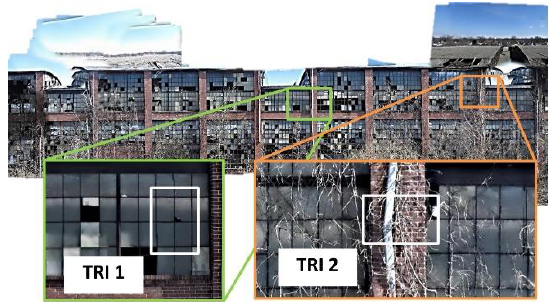
Figure 7. Selection of two sample TRIs (TRI 1 and TRI 2) on the orthophoto. Sensors 2018 , 18 , x FOR PEER REVIEW